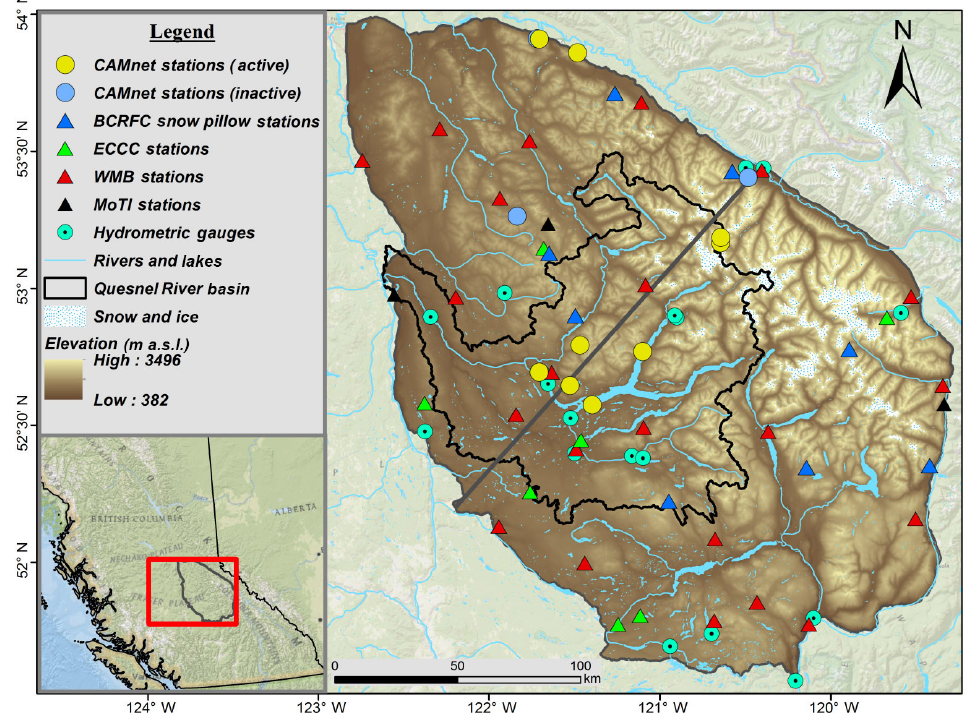
Figure 2. Topographic map of the Cariboo Mountains region including the Quesnel River basin. Dots and triangles show the location of active weather, snow pillow and hydrometric stations operated by different agencies in this region including the BC River Forecast Centre (BCRFC), Environment and Climate Change Canada (ECCC), BC Wildfire Management Branch (WMB), and BC Ministry of Transportation and Infrastructure (MoTI). The grey line depicts a transect between Williams Lake and McBride, BC, for which climate data are extracted (see Fig.